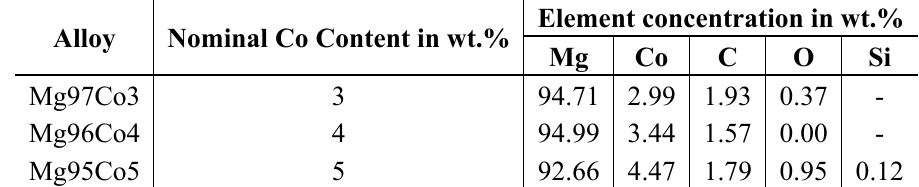
Table 2. EDS measurements of overall Co concentrations in binary Mg-Co alloys. Element concentration in Alloy Nominal Co Content in wt.%